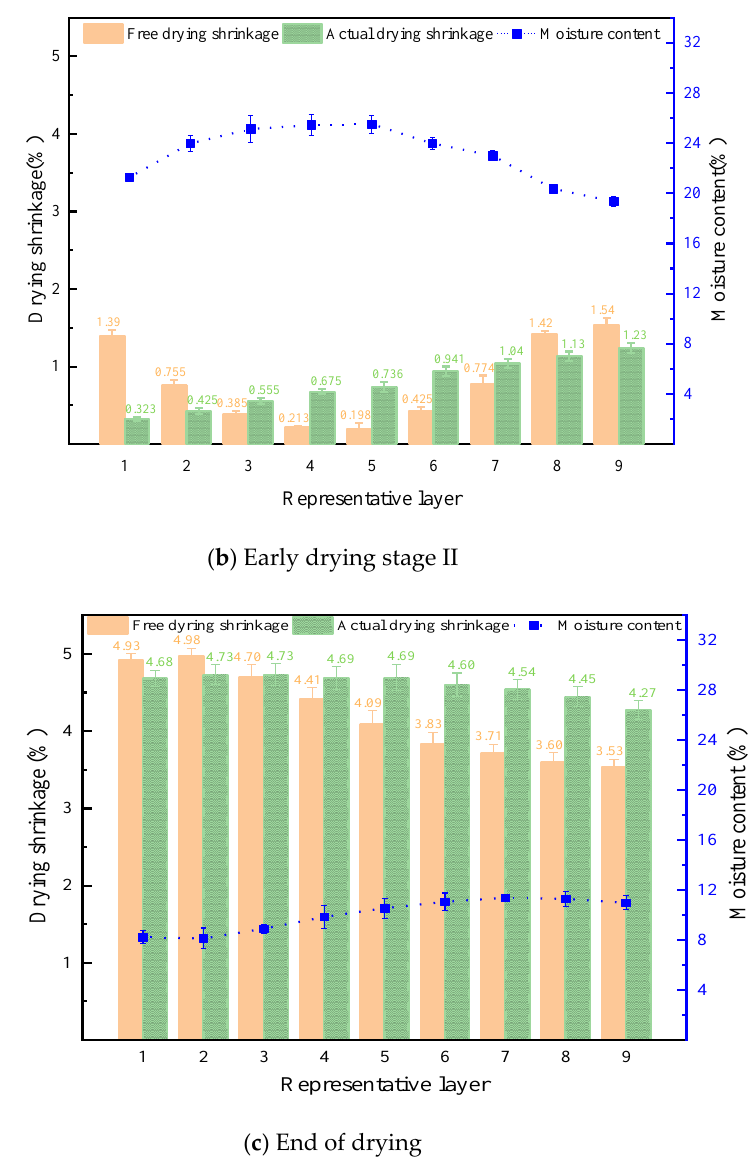
Figure 4. Comparison of the free and actual drying shrinkage of each layer in the thickness of Mongolian Scotch pine at each stage of conventional drying.